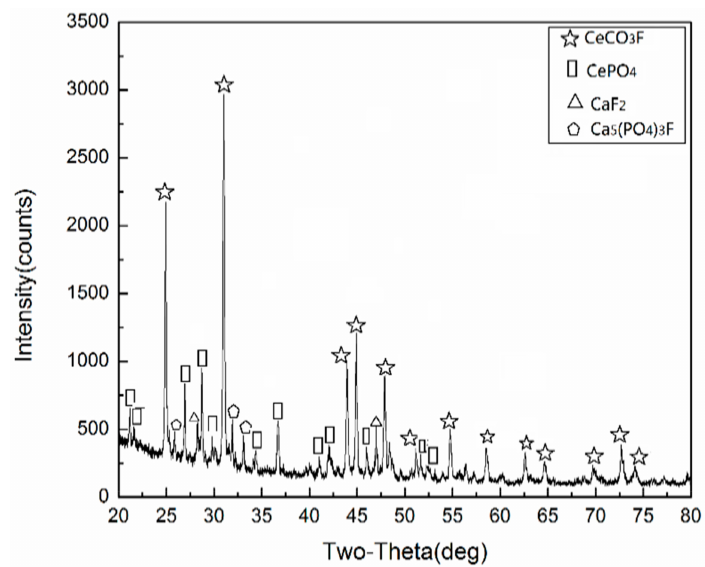
Figure 2. XRD pattern of the rare earth